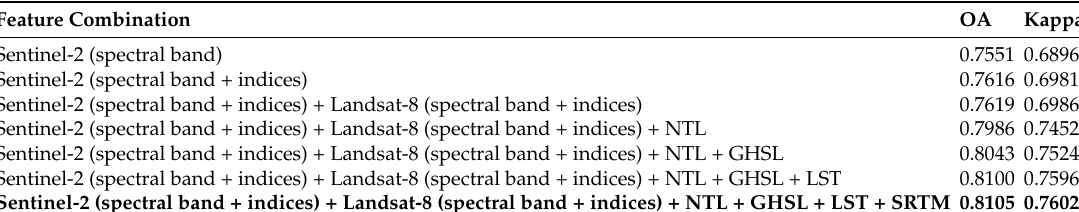
Table 4. Accuracy indices of two evaluation cities (Addis Ababa and Pretoria).